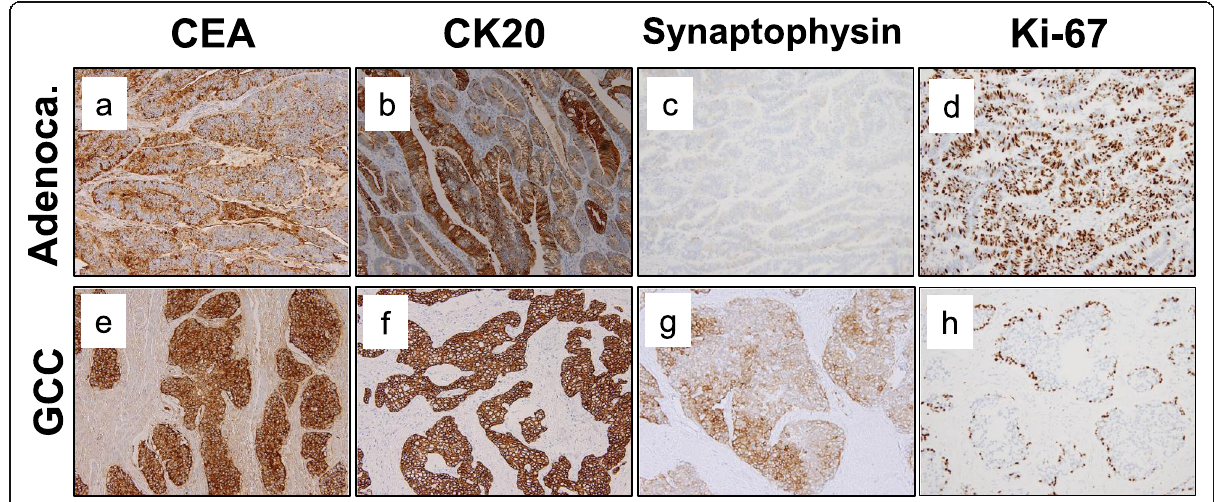
stained positive for CEA ( e ) and CK20 ( f ) as epithelial markers, synaptophysin ( g ) as a neuroendocrine marker by immunohistochemistry. Ki-67 had a different pattern from the adenocarcinoma components ( d ) and GCC ( h ) being diffuse and peripheral in the nests for each area respectively (×20)